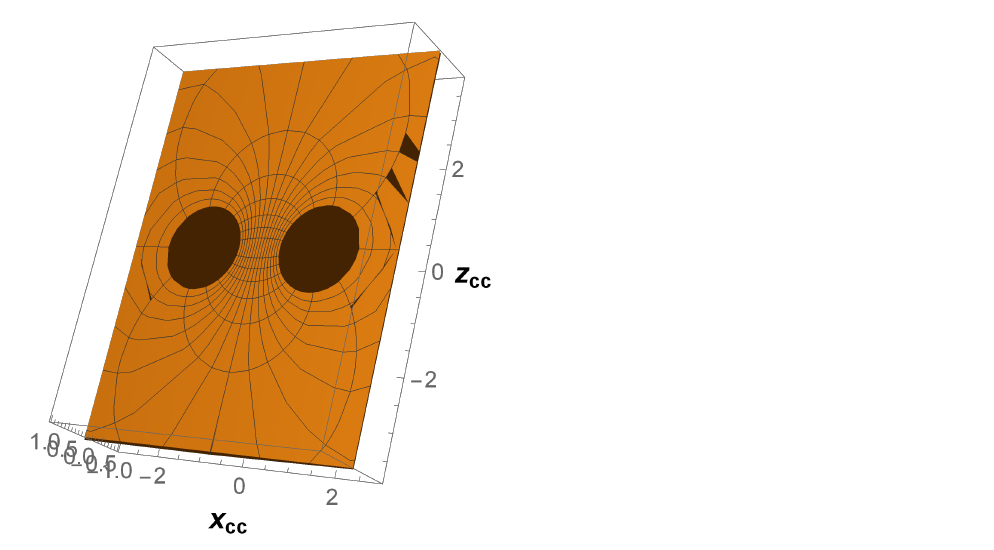
Figure 1. Two-dimensional coordinate system of cap-cyclide geometry with k = 1 and µ close to